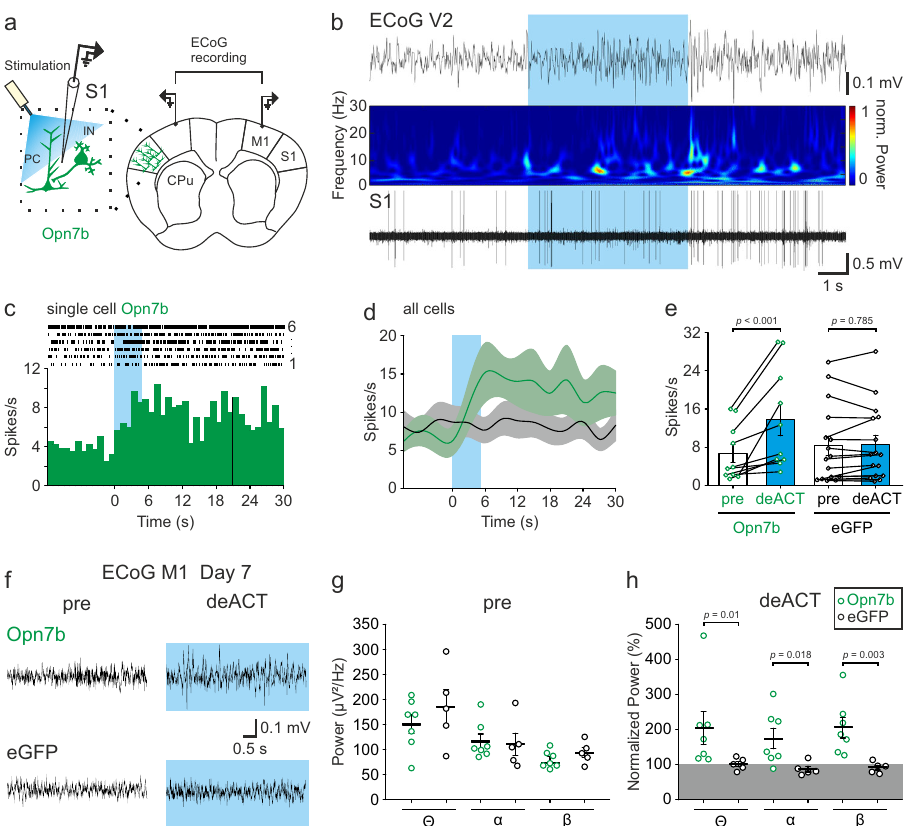
Fig. 3 Blue light stimulation of Opn7b increases neuronal and network activity in vivo. a Schematic description of the unilateral light stimulation site, bilateral electrocorticographic (ECoG) recording site and simultaneous single-cell recording in awake head restrained Opn7b expressing (green) mice. Pyramidal cell (PC); Interneuron (IN); Primary motor cortex (M1); Primary somatosensory cortex (S1); Caudate putamen (CPu). b Example trace depicting a change in activity in the secondary visual cortex (V2) ECoG recording (top), corresponding spectral analysis (middle) and simultaneously recorded single-cell activity (bottom) in the primary somatosensory cortex (S1) after 5 s blue light (465 nm) stimulation on day 10 after injection. c Example raster plot (top) and peri-stimulus time histogram of a single cell in S1 (same one as depicted in B) stimulated with 5 s blue light (blue box) for 6 repetitive trials. Bin size 1 s. d Stimulation increased the single-cell activity in S1 neurons for Opn7b but not enhanced green fl uorescent protein (eGFP; gray) expressing cells (Opn7b n = 10 cells from 3 animals, eGFP n = 16 cells from 3 animals). Solid line represents the mean, while shadowed area represents the ±SEM. e A signi fi cant (repeated measure two-way ANOVA followed by pairwise Bonferroni test, F (1,24) = 21.494, p < 0.001) increase in the mean spike rate (±SEM) upon blue light stimulation (deACT 12 s, blue) compared to pre-stimulation (pre 12 s, white) was found for Opn7b but not eGFP expressing cells. Each circle (Opn7b n = 10 cells from 3 animals, eGFP n = 16 cells from 3 animals) represents an individual cell, while the bar represents the mean. Error bars represented as ±SEM. f Example trace of ECoG activity in M1 before stimulation and during stimulation of Opn7b (top) or eGFP (bottom). g No changes were found in the ECoG activity in the theta, alpha and beta frequency band before stimulation in Opn7b ( n = 7 animals) and eGFP ( n = 5 animals). h A signi fi cant increase in normalized (normalized to pre activity) theta, alpha, and beta (two-sided Mann – Whitney-U-test) frequency-band activity was detectable for Opn7b ( n = 7 animals) stimulated Bl6 mice in comparison to eGFP ( n = 5 animals) stimulated Bl6 mice on day 7. Each circle represents individual animals, while the bar represents the mean. Error bars represented as ±SEM. Source data are provided as a Source Data fi